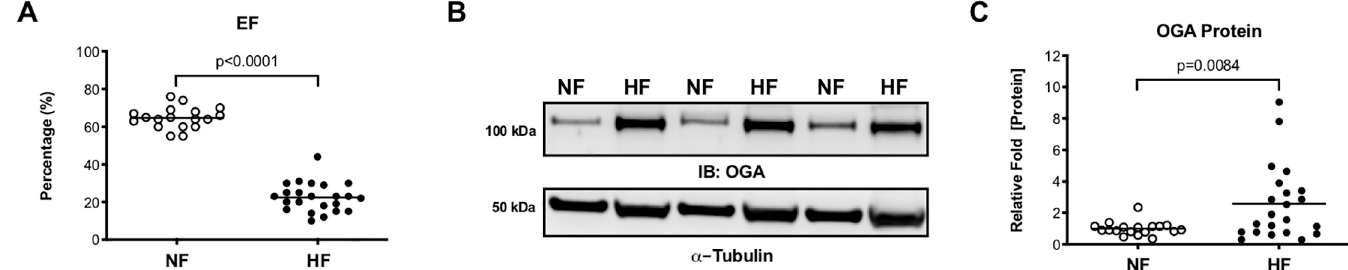
Fig 5. OGA is upregulated in human heart failure. Cardiac tissue from non-failing (NF, n = 18) and failing hearts (HF, n = 23) was used to assess the expression of OGA. Left ventricular ejection fraction (A). Western blot of OGA protein expression (B). Densitometric analysis of OGA western (C). An unpaired Student’s t -test was used to determine significance between NF and HF